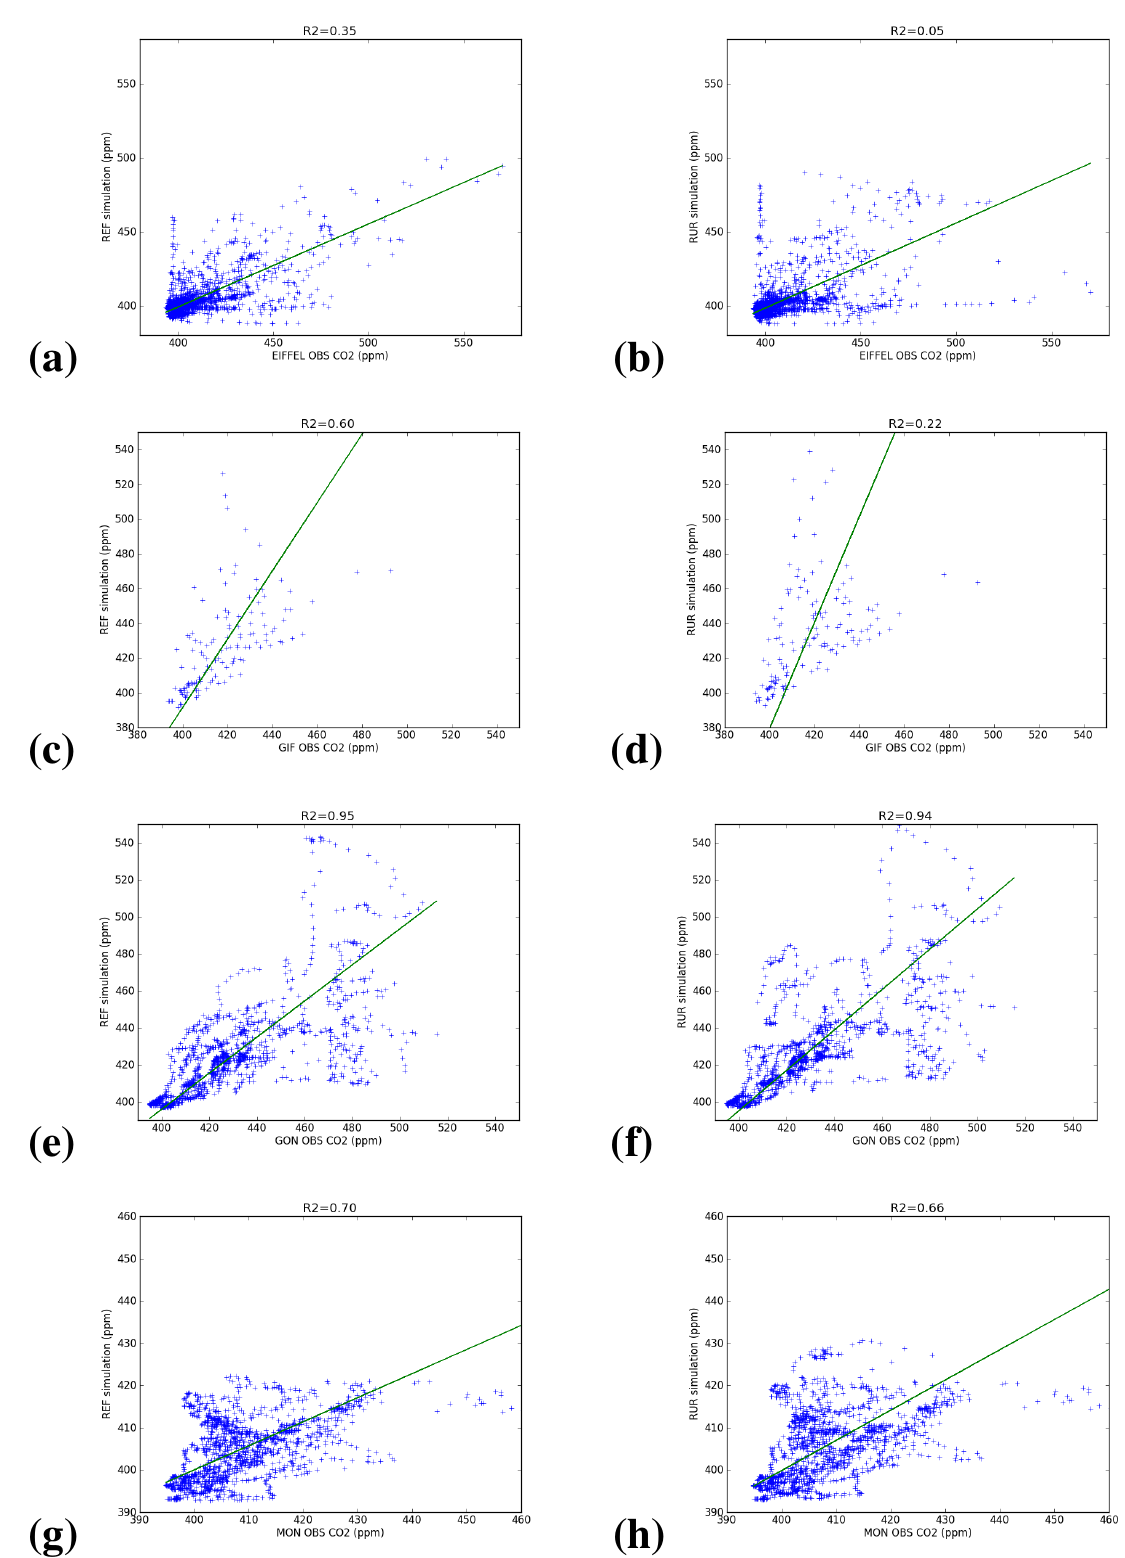
Fig. 12. Scatter plots of the observed (on the horizontal) vs predicted CO 2 mixing ratios for EIF, GIF, GON and MON for REF simulation (on the left) and RUR simulation (on the right), with a linear regression